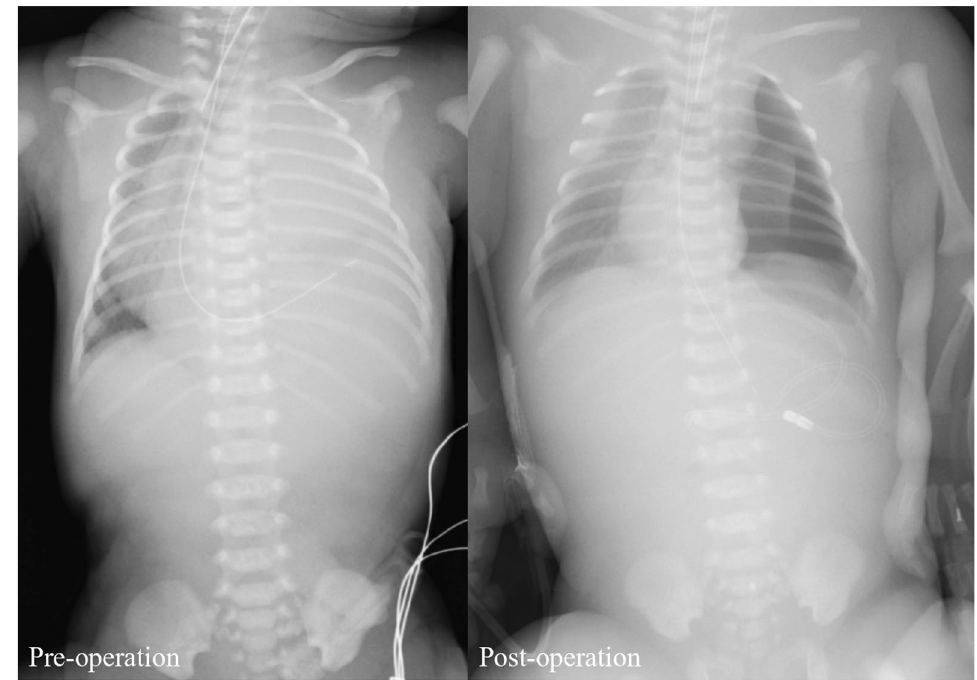
Fig. 1 Chest radiograph showing a left diaphragmatic hernia. Preoperative chest radiograph reveals left diaphragmatic hernia. Postoperative chest radiograph reveals that the prolapsed organs are